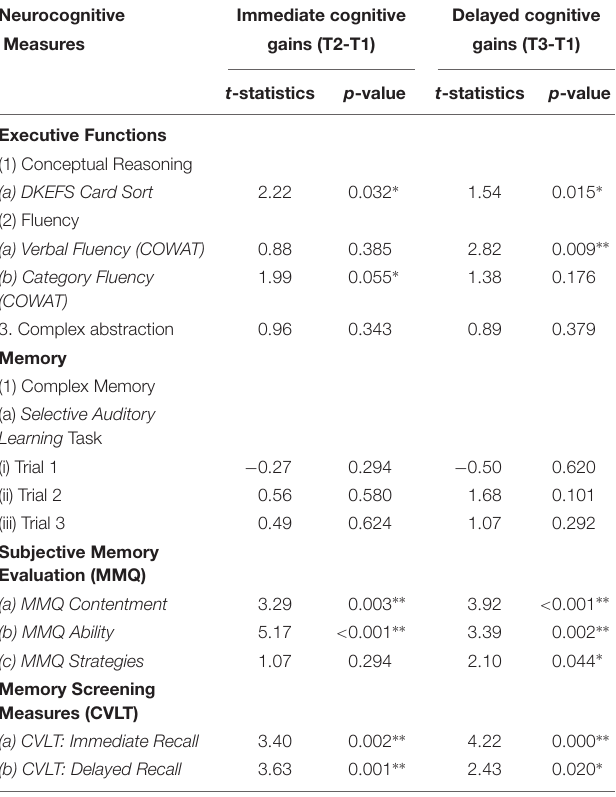
TABLE 5 | Mixed Model: Time Effect on cognitive measures irrespective of group assignment: Immediate cognitive gains (T2-T1), and Delayed cognitive gains (T3-T1) changes in cognitive function in mild cognitive impairment (MCI).